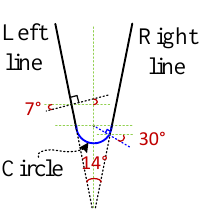
Fig. 5. The gradient directions of lines and the front of the probe.